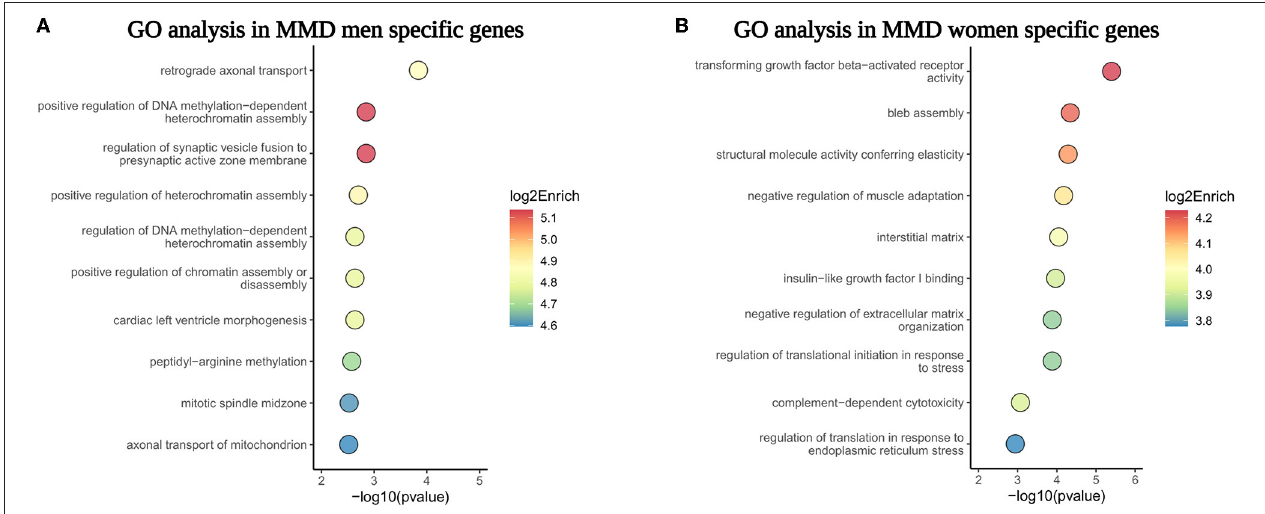
FIGURE 6 | The GO pathway enrichment analysis of sex-specific genes in MCA of men and women patients with MMD. (A,B) Showed the top 10 GO biological processes enriched in male and female sex-specific genes,